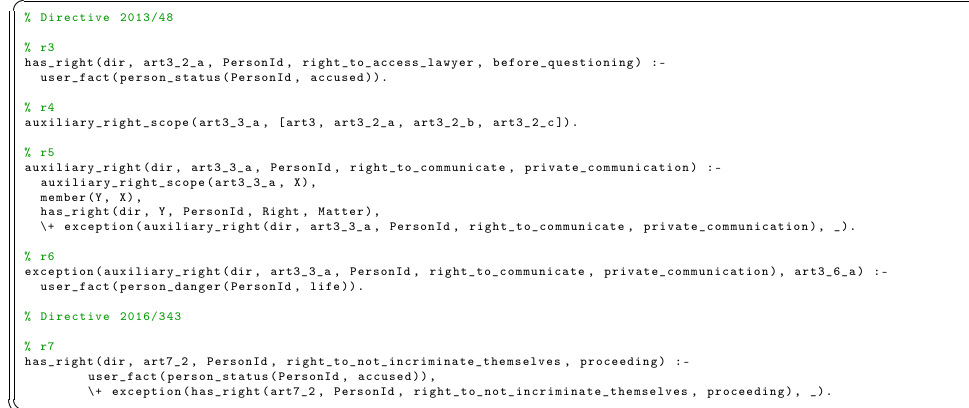
Figure 17. Directive transposition in